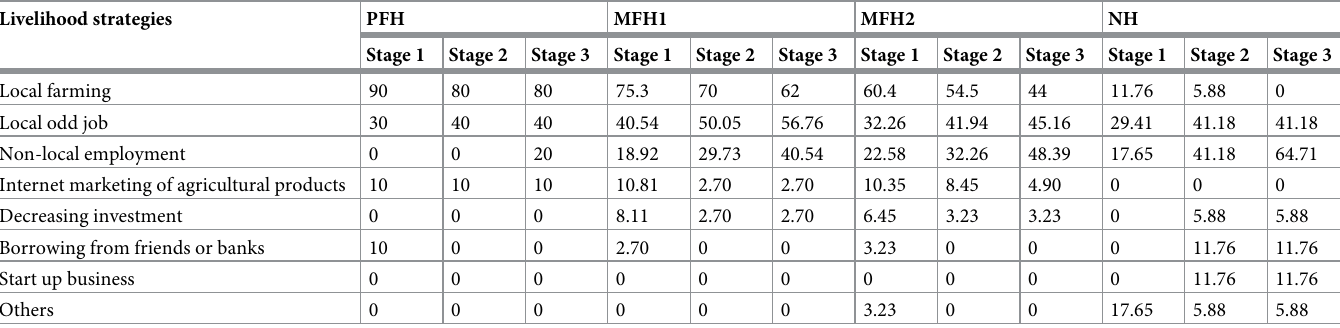
Table 4. Livelihood strategies of different types of rural households in response to the epidemic in various periods (%). Livelihood strategies PFH MFH1